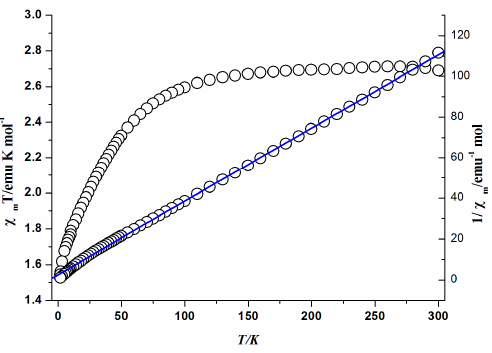
Figure 7. Temperature dependence of χ m T for the complex 1 . The blue solid lines represent the best fitting in the temperature range of 2–300 K.